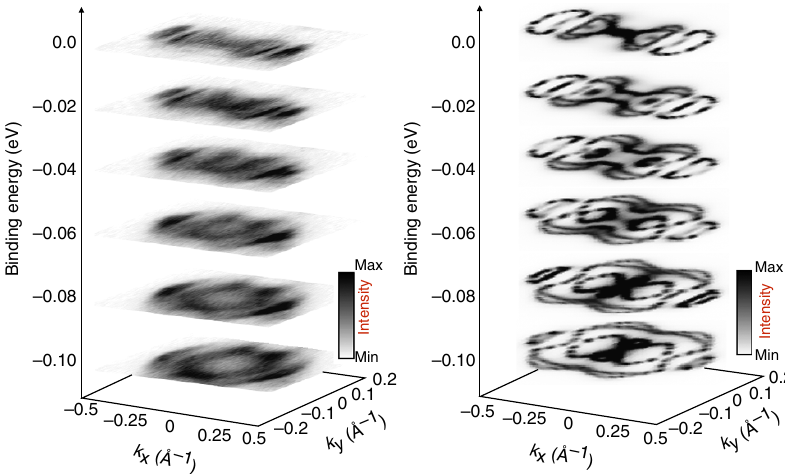
Figure 3 | Fermi surface topography. Constant energy cuts from E F down to 100meV binding energy (in steps of 20meV). Left: experimental spectra measured at a photon energy of 68eV and at 77K, right: theoretical calculations for bulk WTe 2 at k z ¼